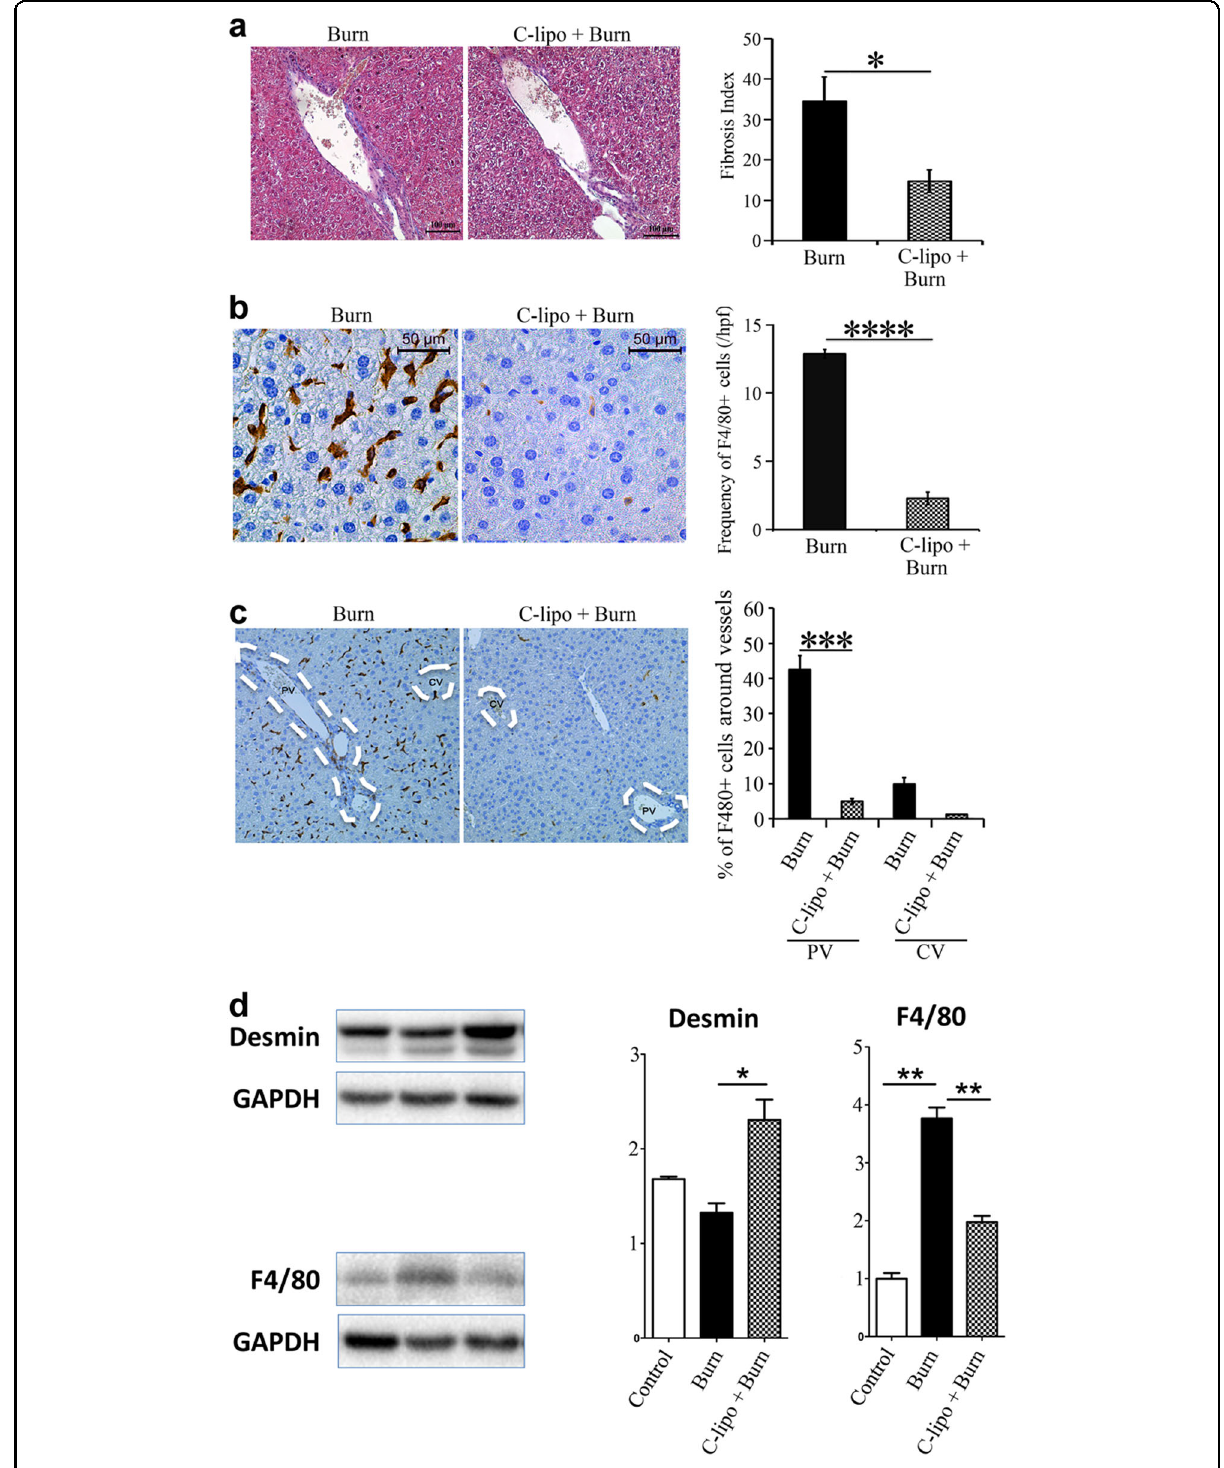
Fig. 3 Myeloid cells have an essential role in the induction of fi brosis post-thermal injury . a Mice treated with liposomal clodronate compared with control treated group. Trichrome staining shows less fi brosis around portal venules post-thermal injury when myeloid cells are depleted; n = 9, scale bar 50 μ m. b Immunohistochemistry shows a highly effective ablation of F4/80 + cells in liposomal clodronate-treated group in comparison to the control group; n = 9, scale bar 50 μ m. c There is a global ablation of F4/80 + cells in the liver of mice treated with liposomal clodronate, scale bar 100 μ m. d In contrast to earlier fi ndings, without F4/80 + cells, there is an increase in desmin + cells post-thermal injury; n = 3. * P < 0.05, ** P < 0.01, *** P < 0.001, **** P <